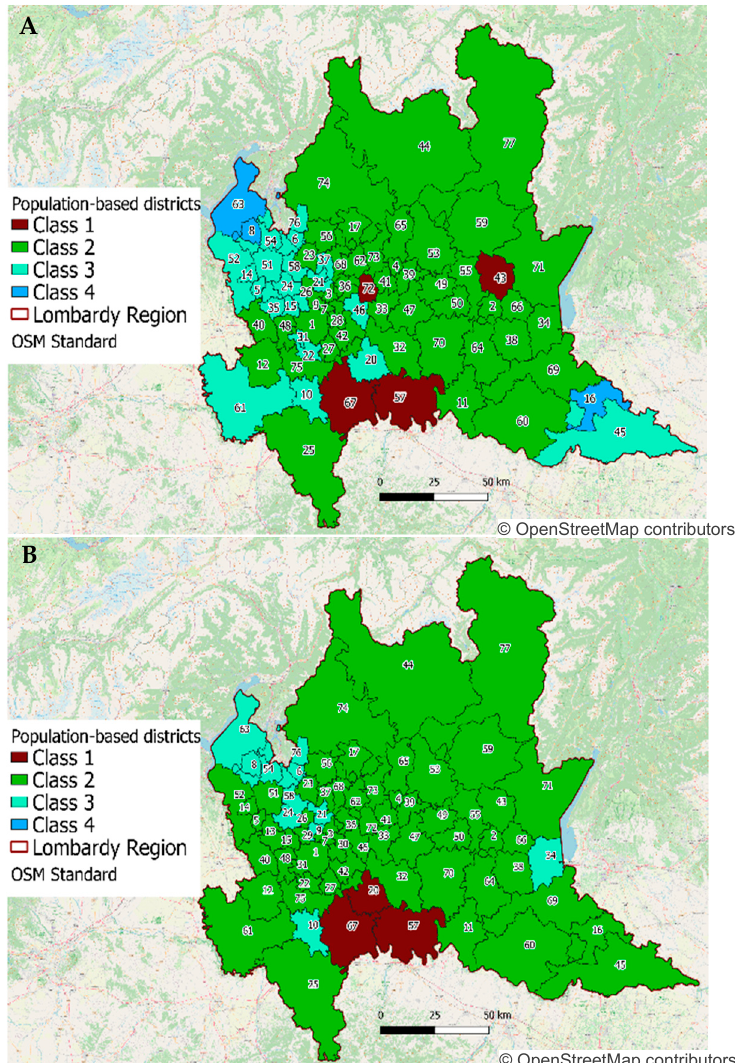
Figure 7. Mapping of the different classes attributed to the time-series of COVID-19 score ( A ) and of normalized emergency calls ( B ) for each cluster (ID# for each cluster reported in the map), based on their data morphology. Class 1 is characterized by very sharp and evident raising curves, class 2 by evident but smoother raising curves, class 3 by detectable but smaller raising curves (implying a lower signal-to-noise ratio), class 4 by no raising trend in the curves.